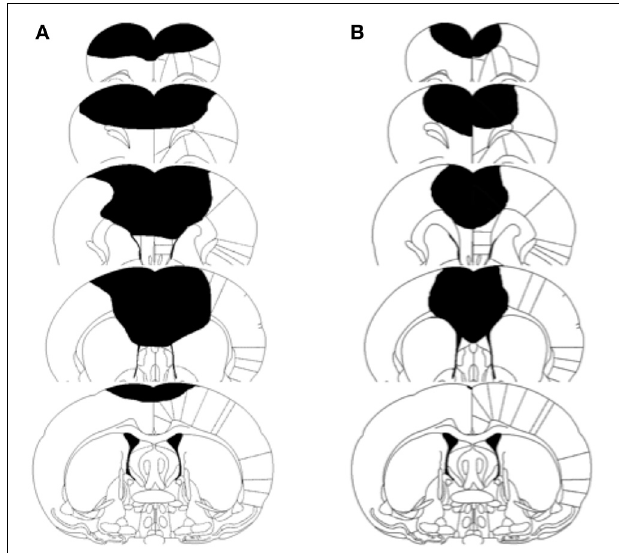
FIGURE 4 | Schematic illustration of lesion size in two representative brain injured animals. (A) Represents cagemom animal. (B) Represents condomom animal.